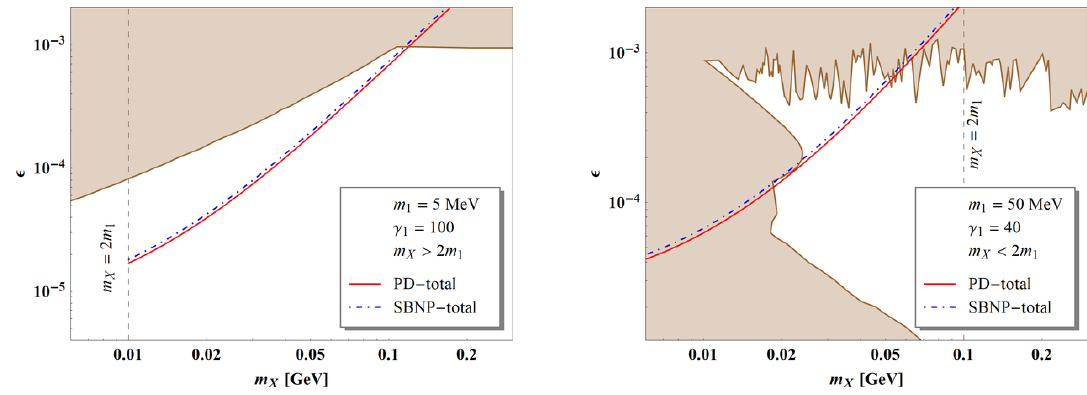
Figure 6 . Experimental sensitivities in the dark photon model parameters m X (cid:0) (cid:15) . Our limits are given by BDM searches in the elastic electron scattering channel arising in the benchmark model described in (4.5). The left (right) panel exhibits the result for the case where the dark photon X decays invisibly (visibly), with one-year data collection from all sky. The brown-shaded regions show the current excluded parameter space by 90% C.L., according to the reports in refs. [51] (left panel) and [52] (right panel). For both cases, the dark-sector gauge coupling g is set to be unity for